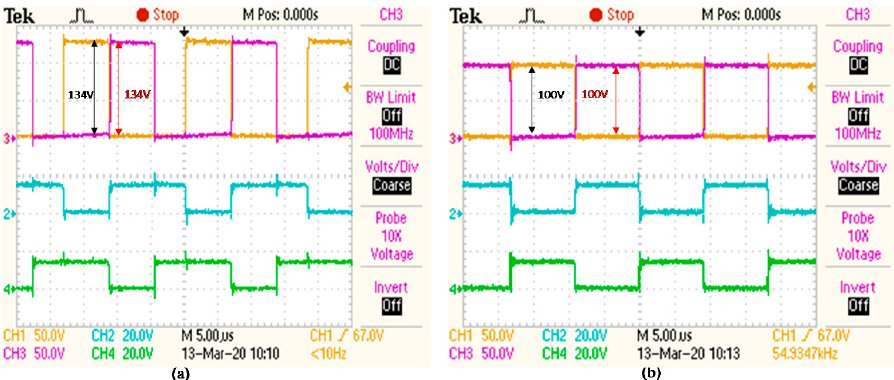
Figure 14. The comparison of voltage stress on switches ( a ) and diodes ( b ).